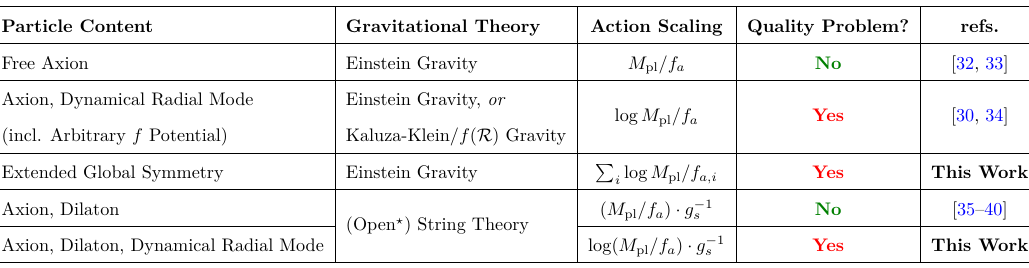
Table 1 . The scaling of the action for wormhole configurations in different particle physics and gravitational scenarios. ? Note that closed strings with a single dilaton do not support such wormhole configurations